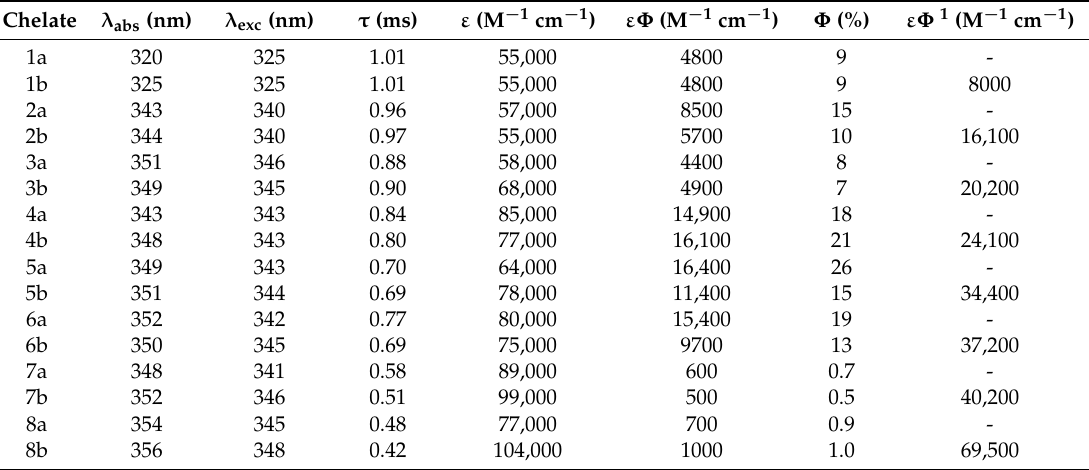
Table 1. Absorption maxima ( λ abs ) and excitation maxima ( λ exc ), luminescence decay times ( τ ), molar absorption coefficients ( ε ), brightness ( ε Φ ) and quantum yields ( Φ ) in TRIS buffer (pH 7.75) as well as the enhanced brightness on dried